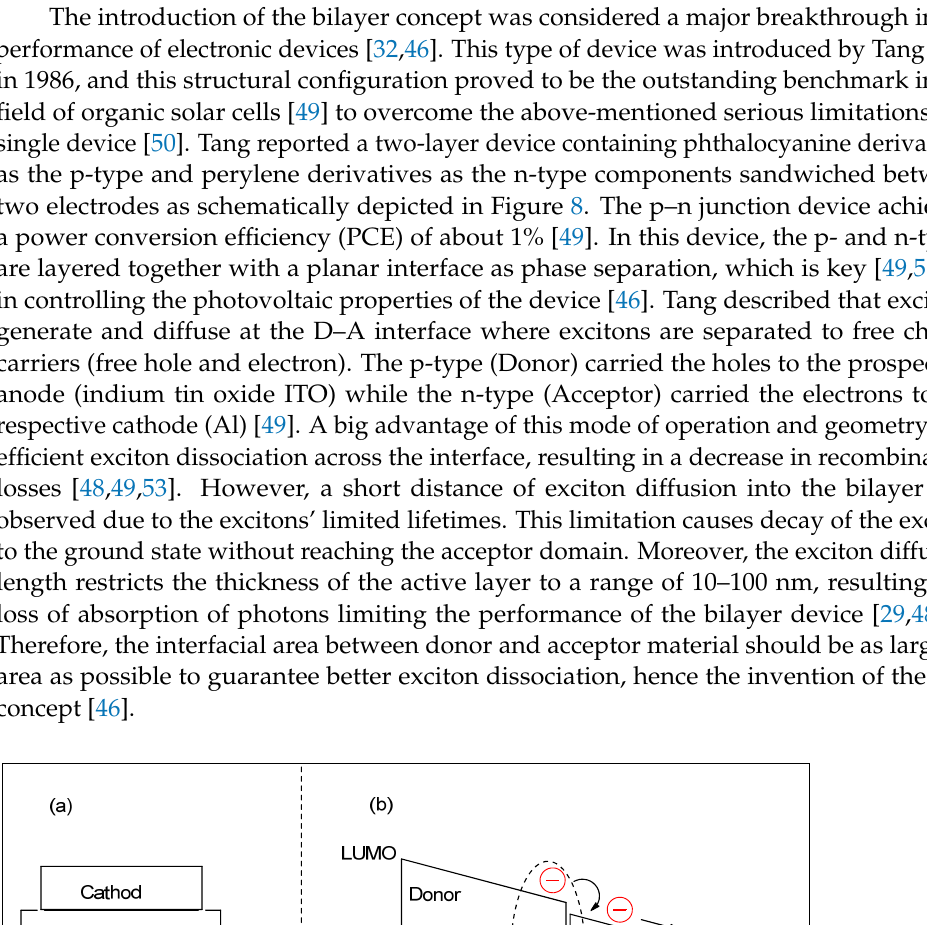
Figure 7. ( a ) Schematic of a single organic device. ( b ) In a p-type Schottky contact at the metal cath- ode, photogenerated excitons are dissociated in a thin depletion region W.